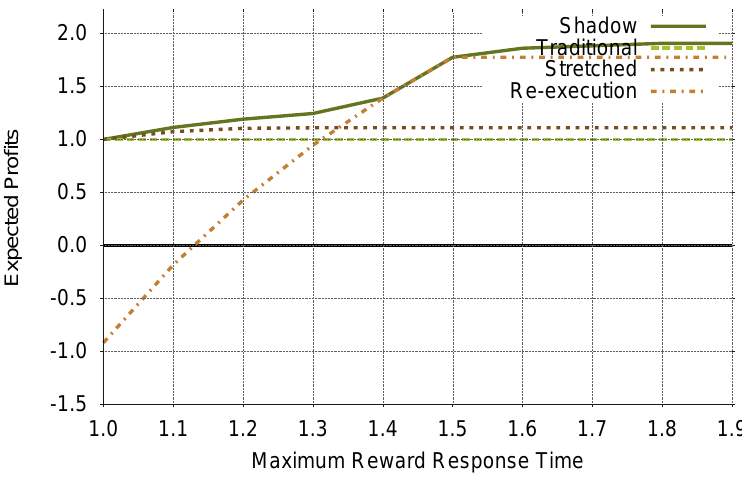
Figure 4. Profit for different response time threshold. ρ = 0.5, MTBF = 5 years, N = 100,000, W = 1 h.